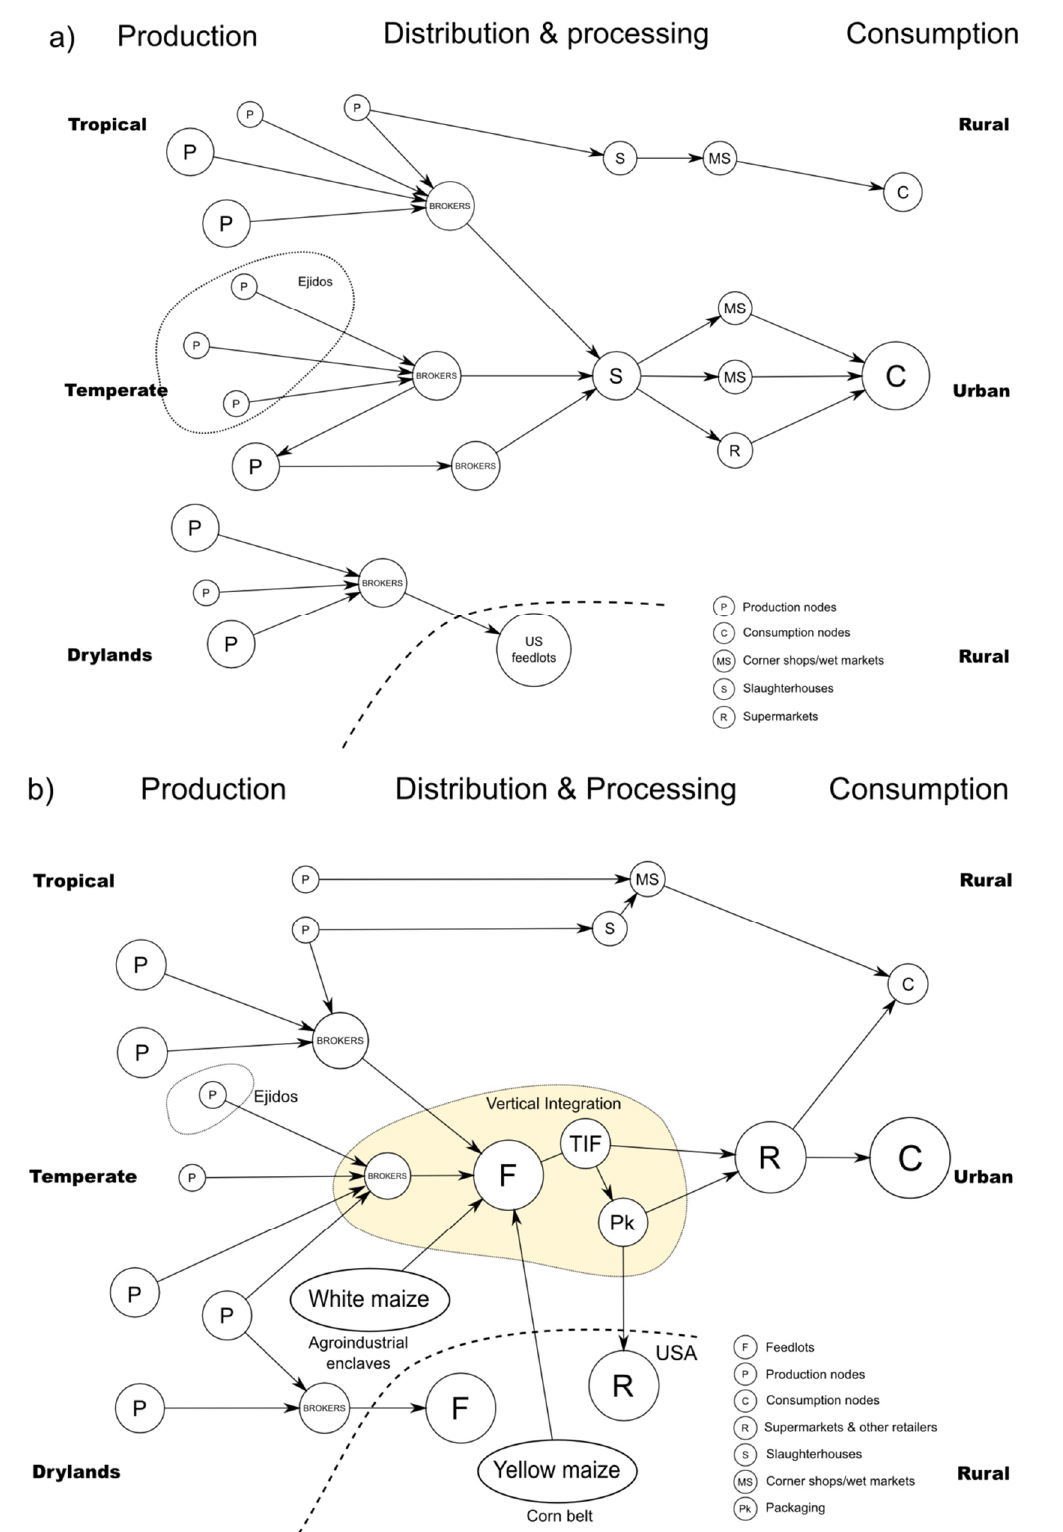
Figure 4. ( a ) Pre-reform period beef-cattle commodity chain and ( b ) post-reform period maize-cattle